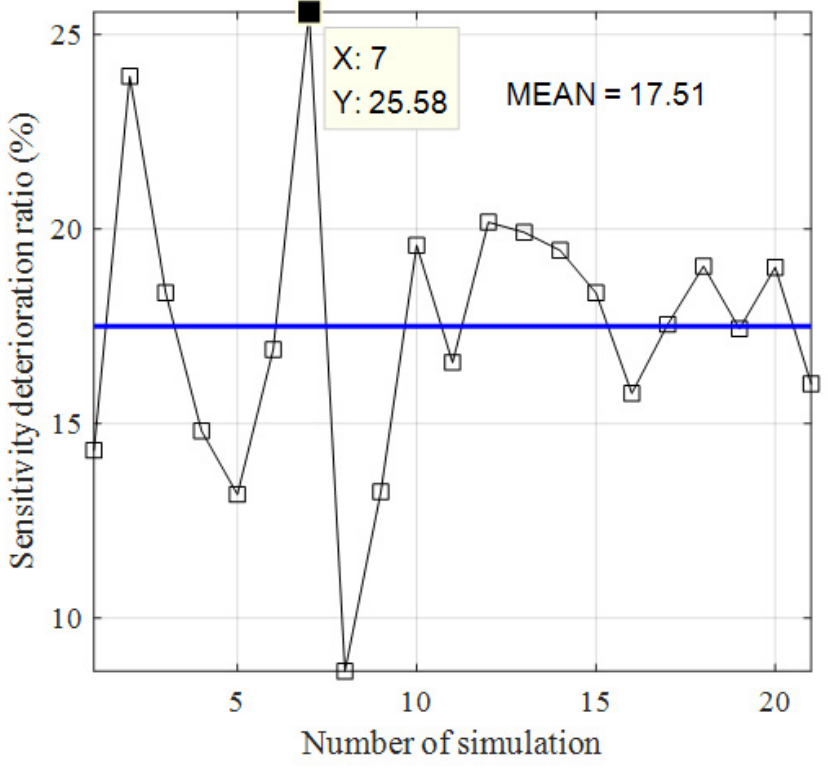
Figure 15. The sensitivity deterioration ratio obtained from varying the parameters of integration time, spectral resolution, and quantization bits. According to Figures 12b, 13b, and 14b, we considered the 7 different sensitivity deterioration results under each parameter as 7 complete simulation results. Figure